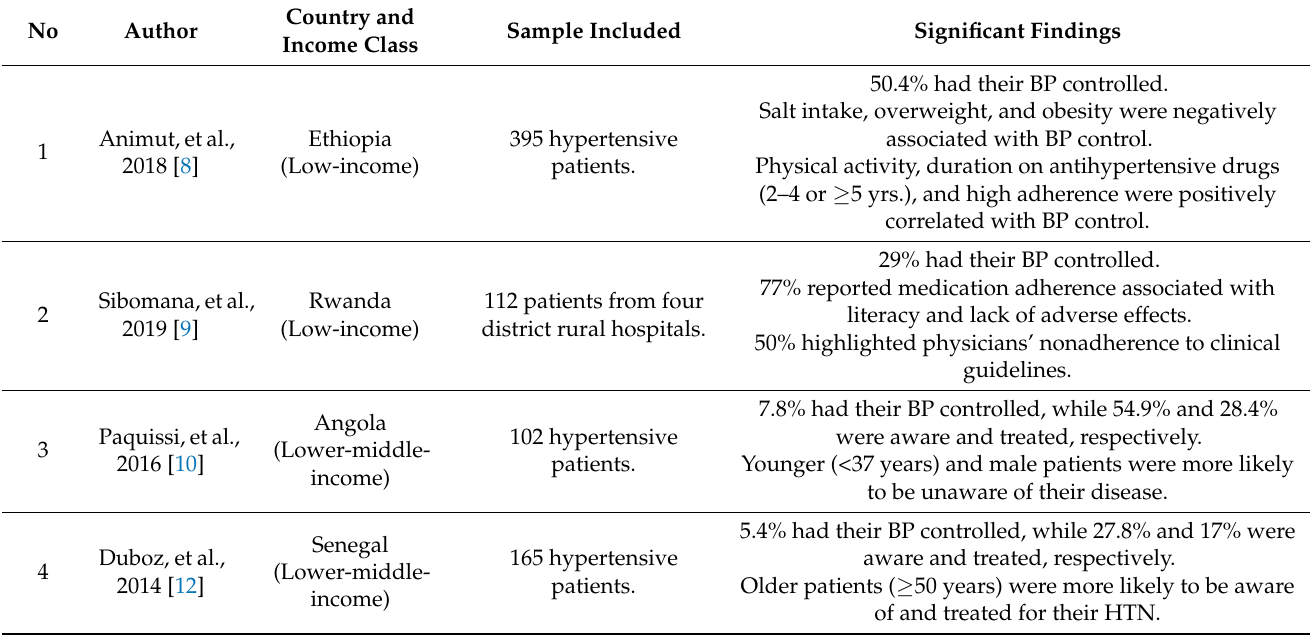
Table 1. Summary of the included studies and their relevant characteristics ( n =